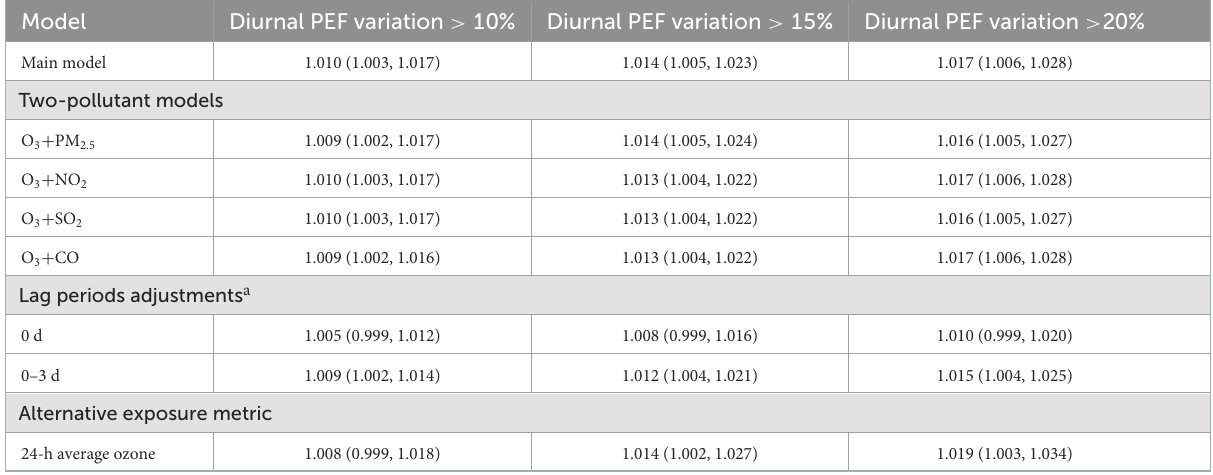
TABLE 3 Odds ratios of asthma exacerbations associated with a 10 µ g/m 3 increase in ozone concentration (lag 0–2 days) in the main model and sensitivity analysis.